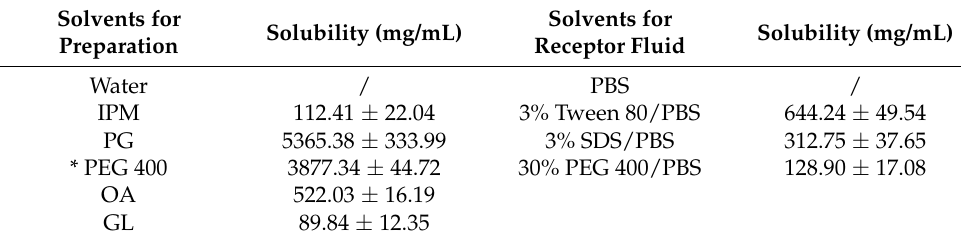
Table 3. Solubility of AA in different solvents (n = 3). Solvents